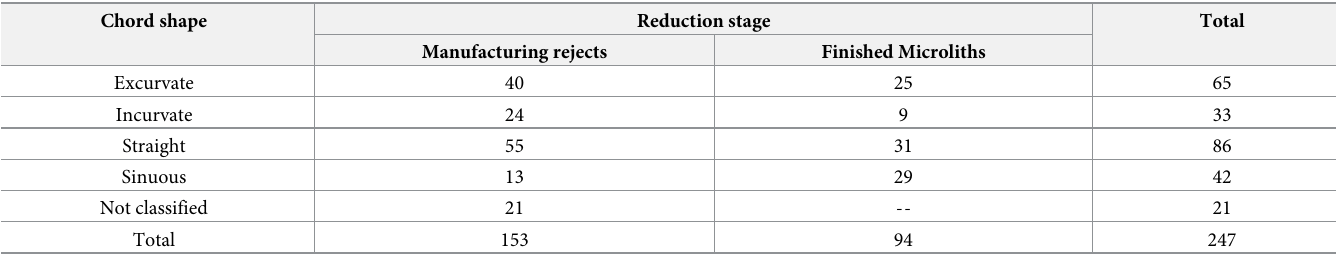
Table 10. Backed microlith chord shapes, Horizon IV, Saruq al-Hadid. Chord